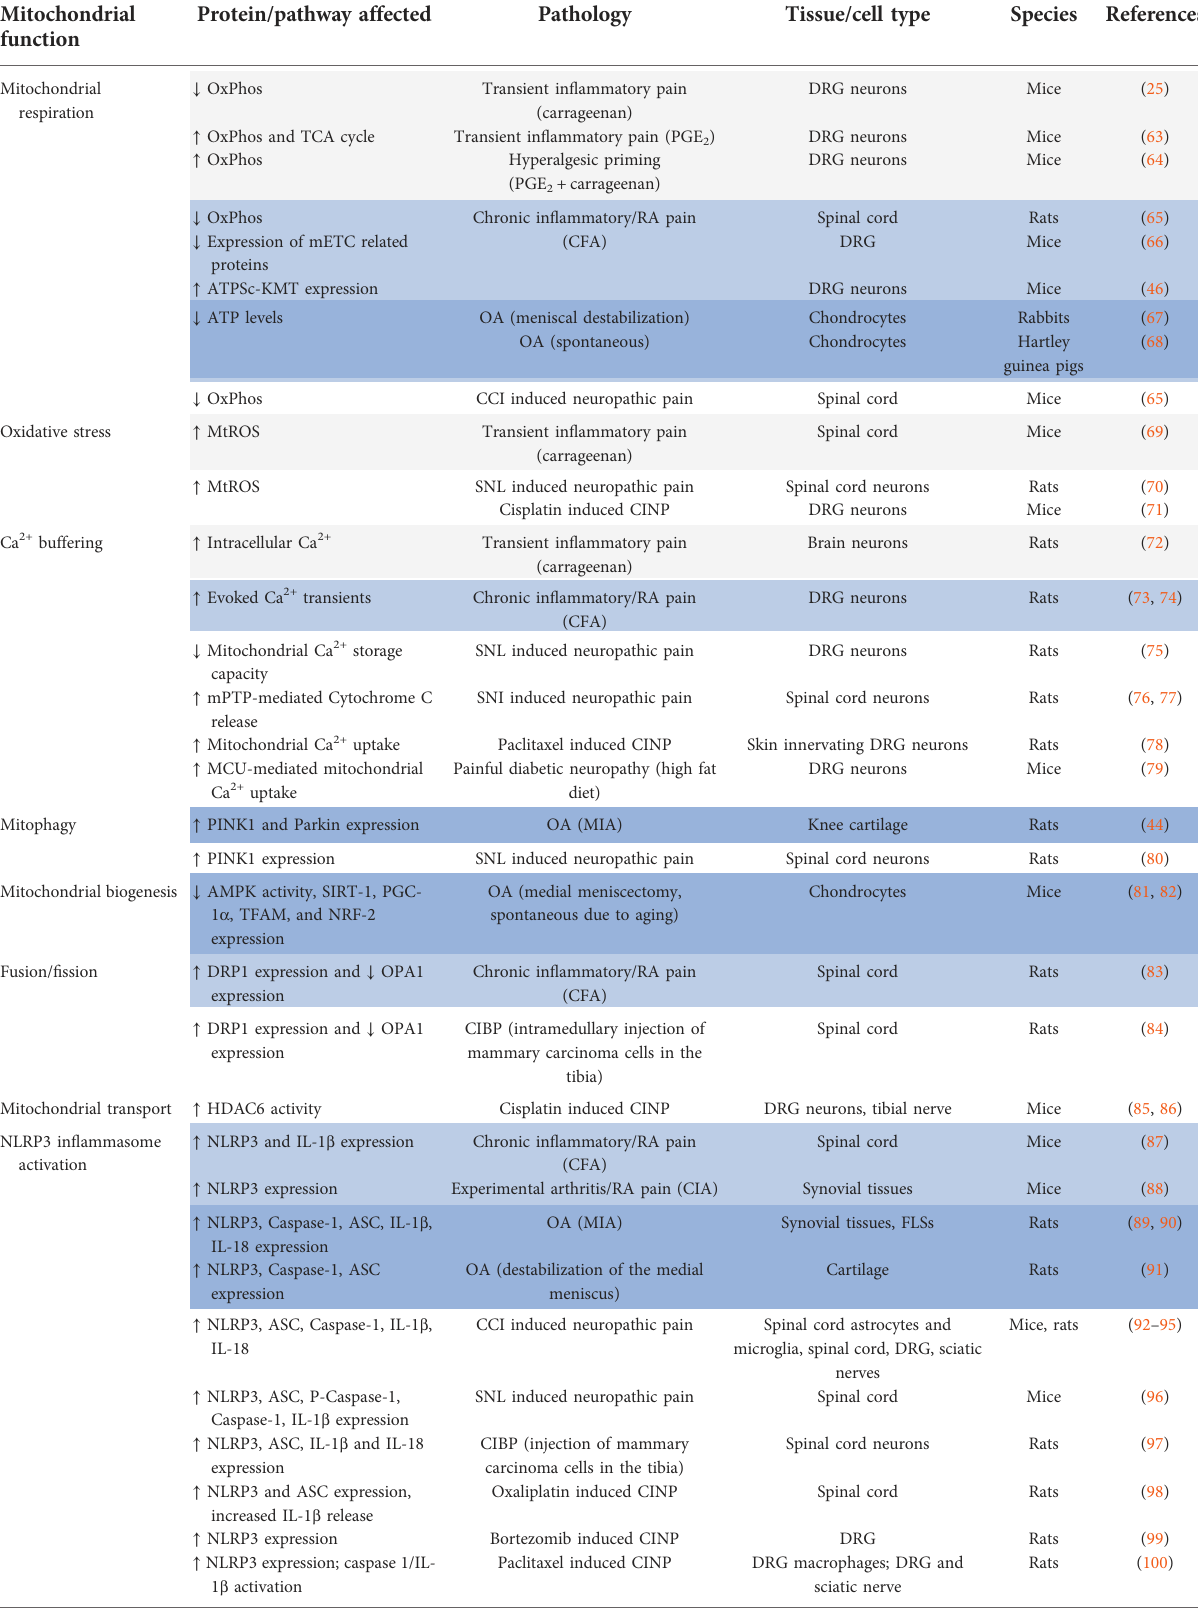
TABLE 1 Detailed overview of pre-clinical fi ndings showing mitochondrial dysfunction in in fl ammatory and neuropathic pain